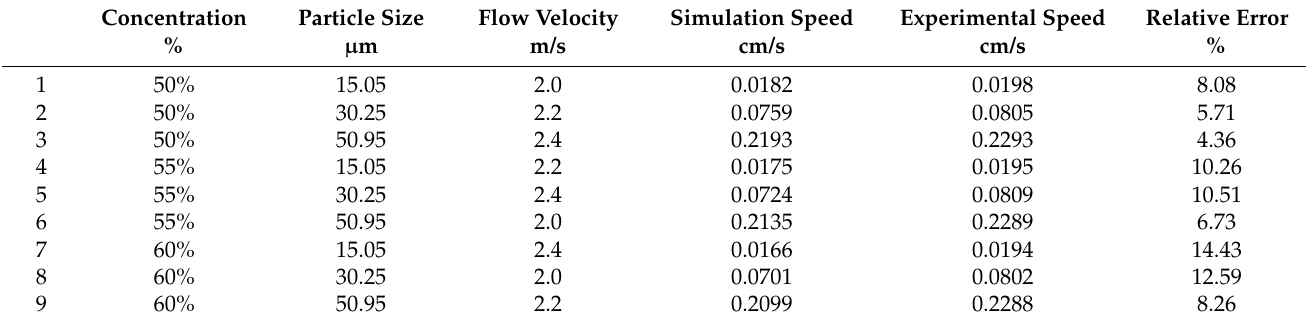
Table 10. Results of simulation and